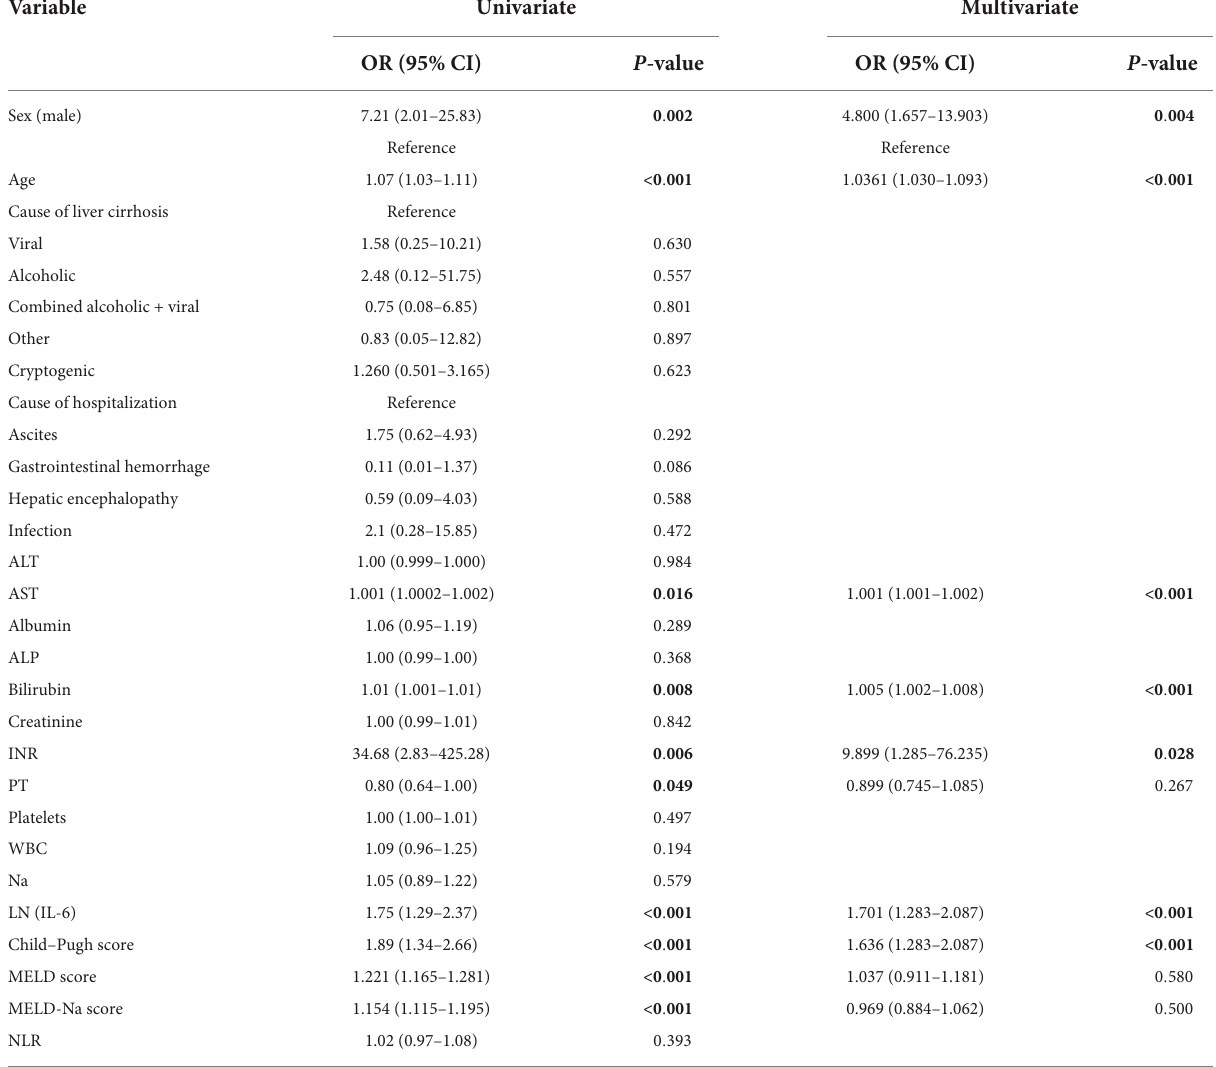
TABLE 3 Univariate and multivariate analyses.